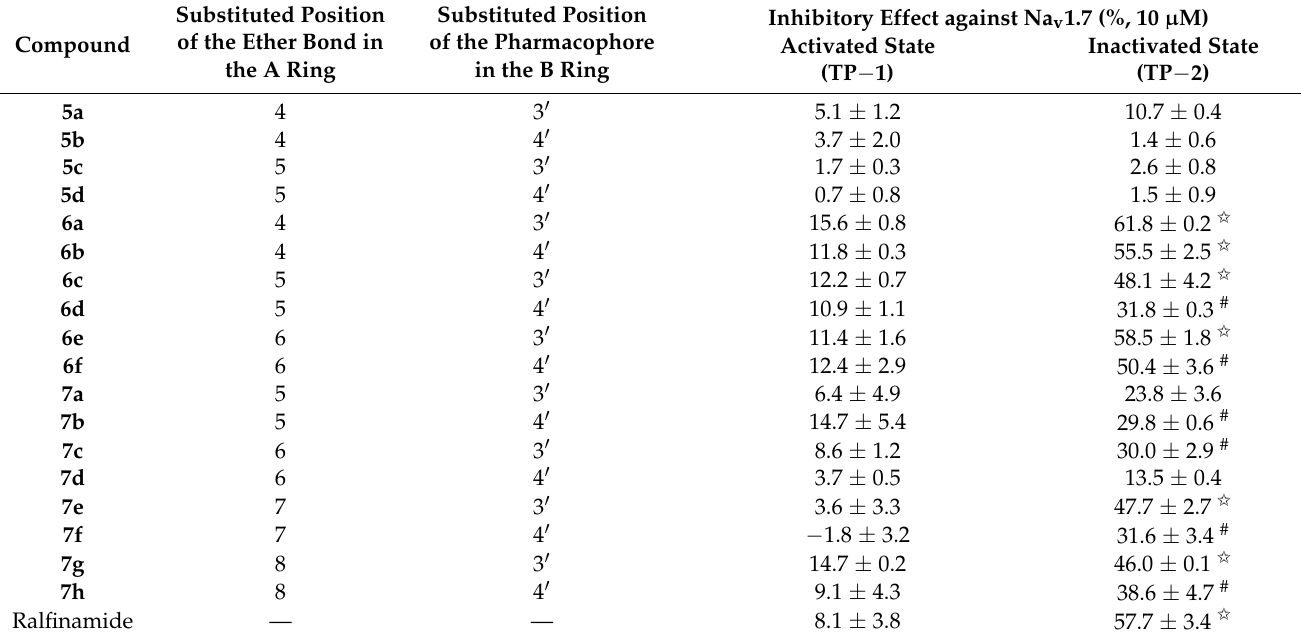
Table 3. Inhibitory activity of the compounds against Na v 1.7.